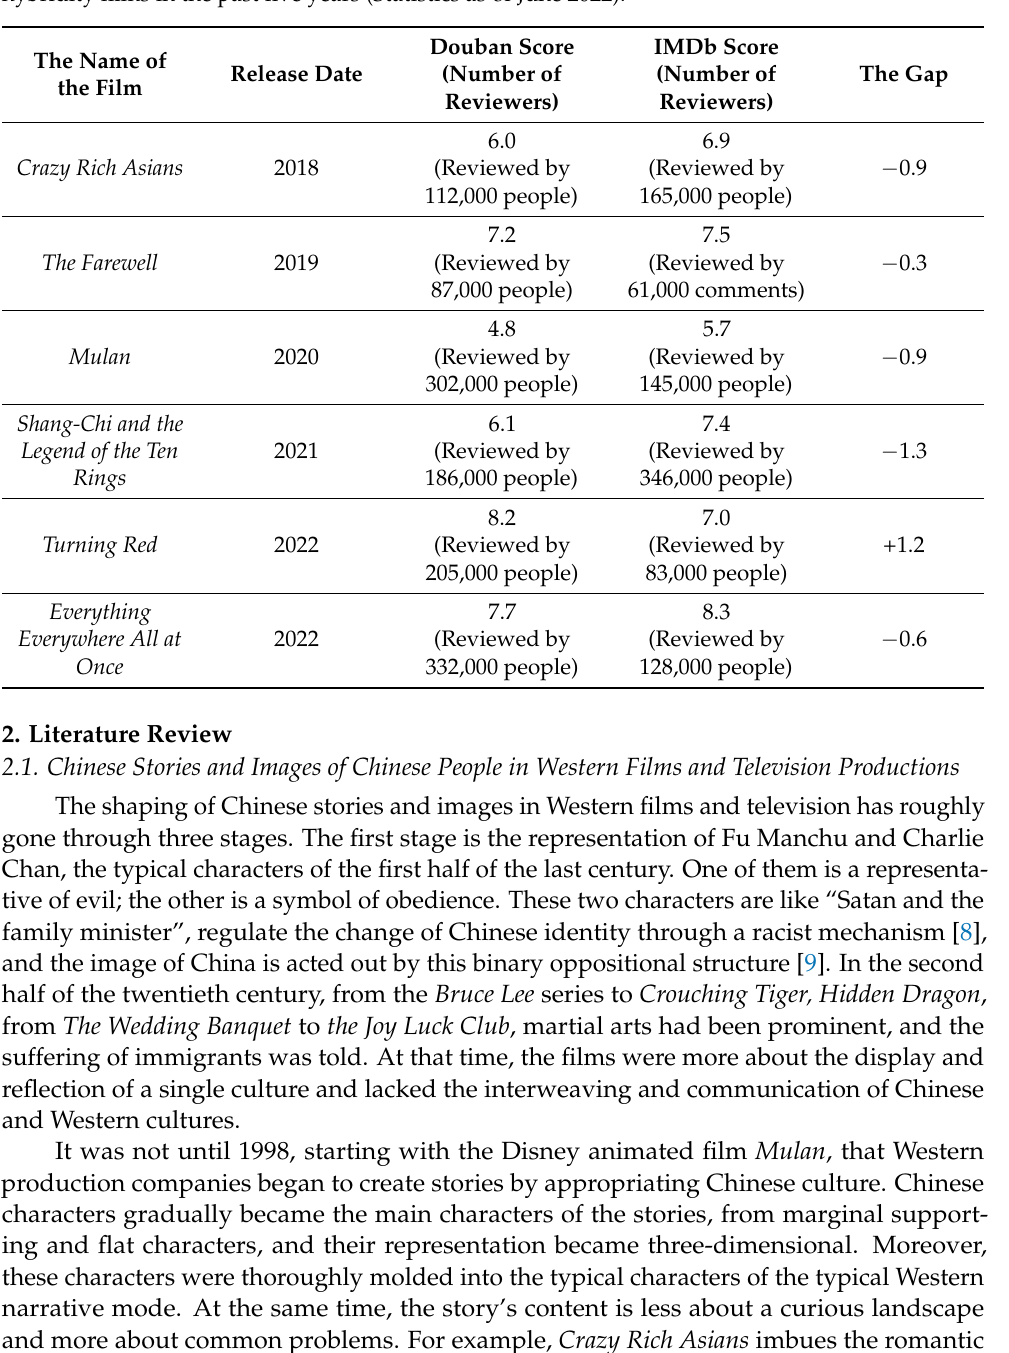
Table 1. Comparison between the scores of Douban and IMDb for Chinese and Western cultural hybridity films in the past five years (Statistics as of June